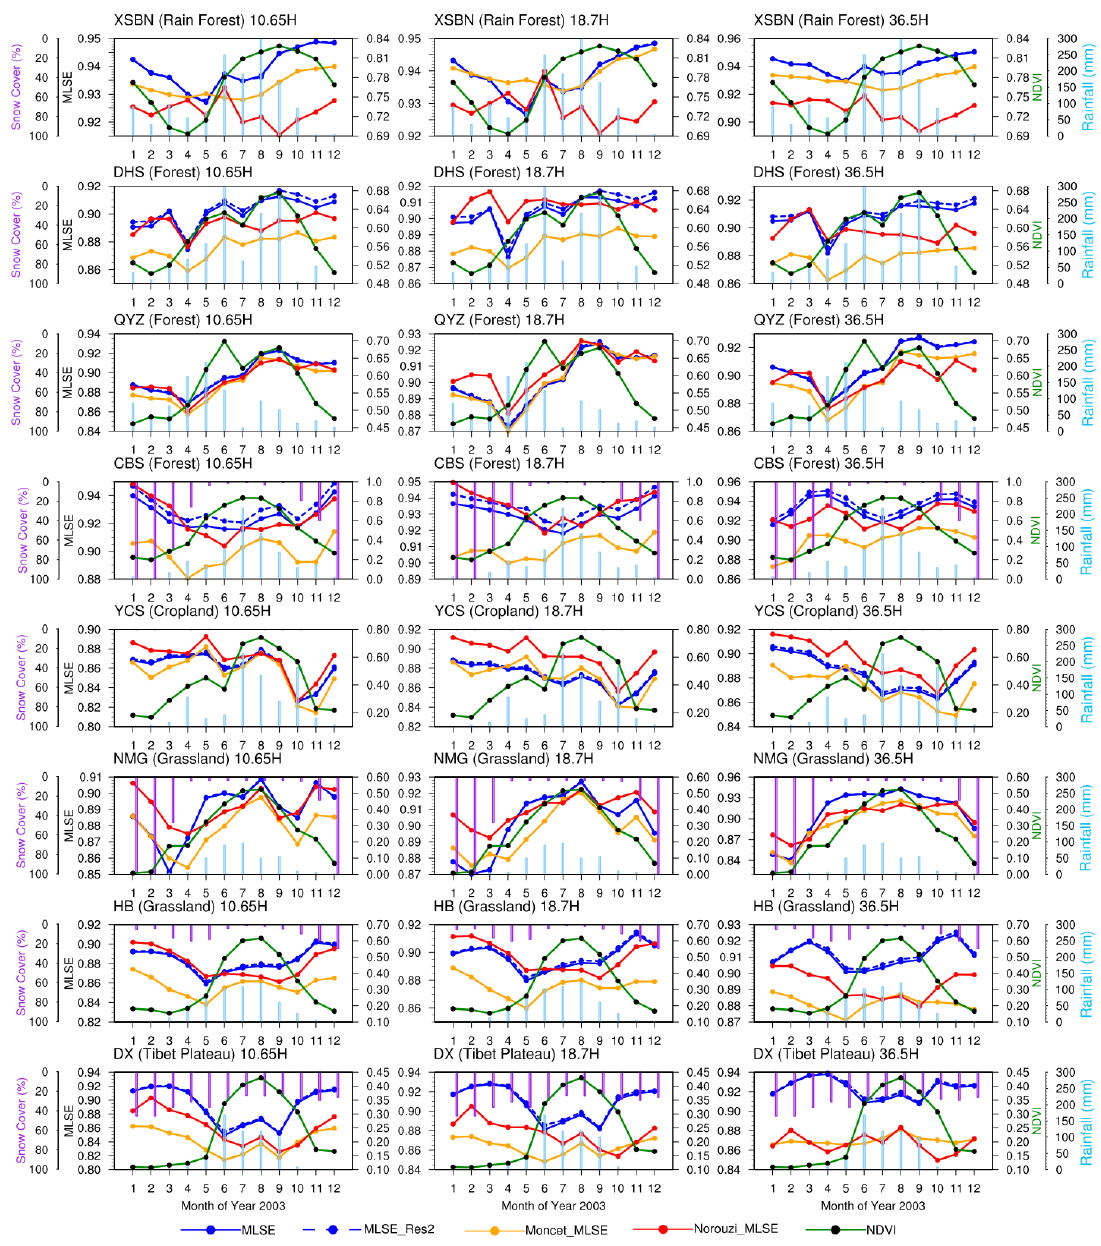
Figure 9. Seasonal variations of four AMSR-E emissivity products (horizontal polarization): MLSE (blue solid line) in this study, MLSE_Res2 in this study (blue dashed line), Moncet’s MLSE (orange solid line), and Norouzi’s MLSE (red solid line) at the 8 ChinaFlux sites in 2003, along with the MODIS NDVI (black dotted green solid line), GPCC rainfall (sky blue bars) and MODIS snow cover (purple bars).